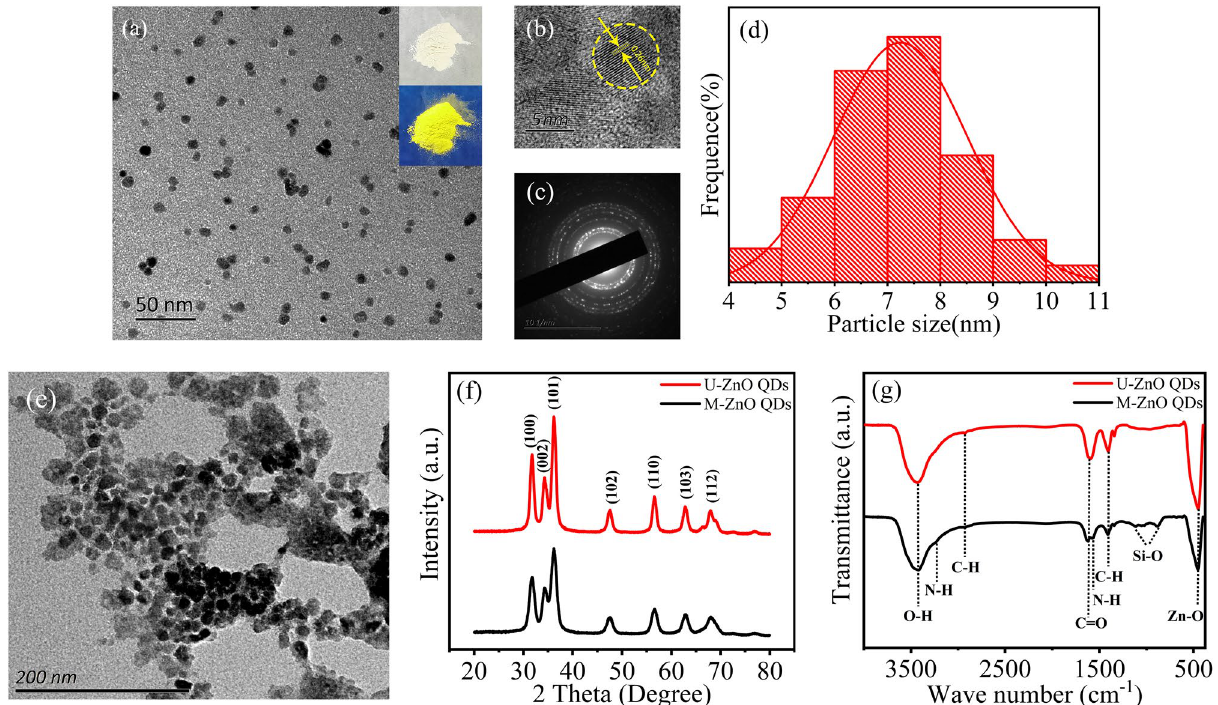
Figure 1. ( a ) A TEM image of M-ZnO QDs (The inset shows the effect of M-ZnO QDs powder under D65 light and UV light). ( b ) A HRTEM image of M-ZnO QDs. ( c ) A SAED pattern of M-ZnO QDs. ( d ) A histogram of the particle size distribution of M-ZnO QDs. ( e ) A TEM image of U-ZnO QDs ( f ) The XRD patterns of U-ZnO QDs and M-ZnO QDs. ( g ) The FTIR spectra of U-ZnO QDs and M-ZnO